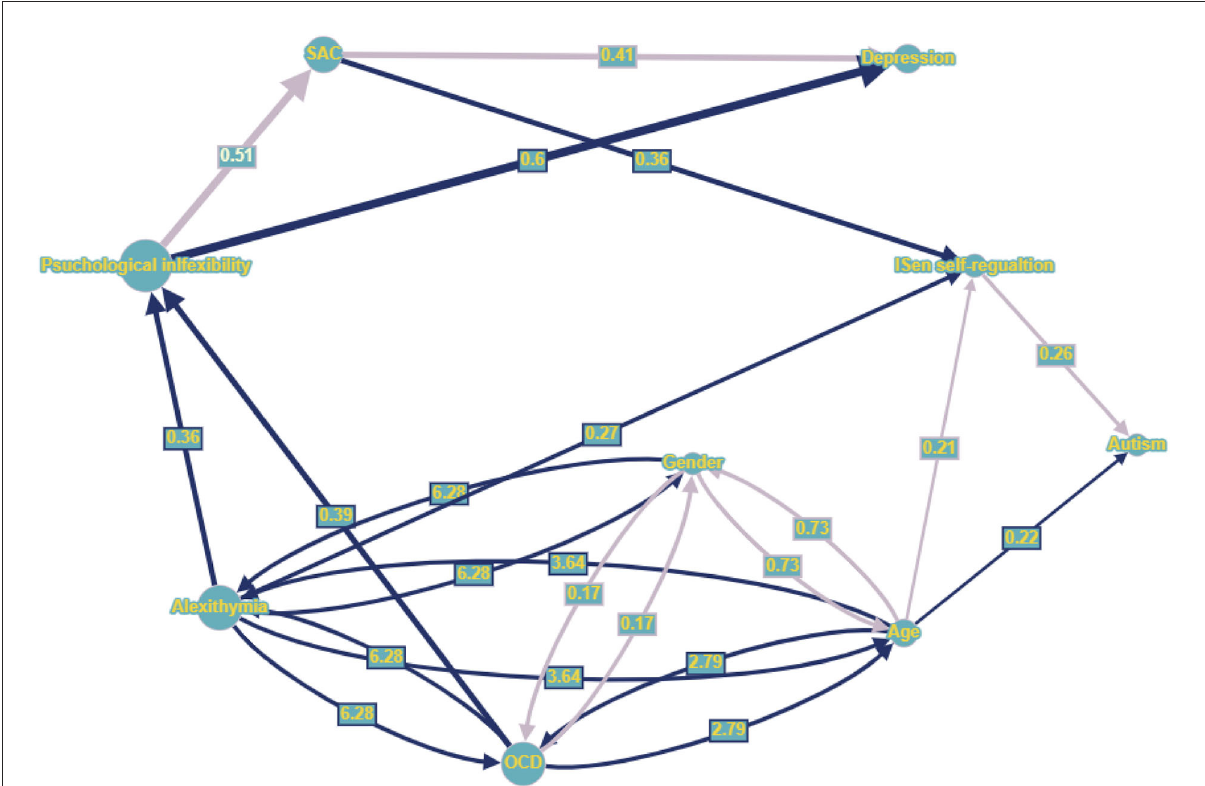
FIGURE4 Graph nodes and edges representation (larger nodes and wider lines indicates those with greater effect within the network), whereby dark blue directed lines indicate positive standardized regression coefficients (only significant coefficients presented), light purple directed line represent negative regression coefficients. Dark blue bidirectional lines represent positive covariance (line width given by correlational value), while light purple bidirectional lines represent negative covariance. Numbers centered on directed lines indicate standardized beta coefficients and bidirectional lines indicate covariance estimate